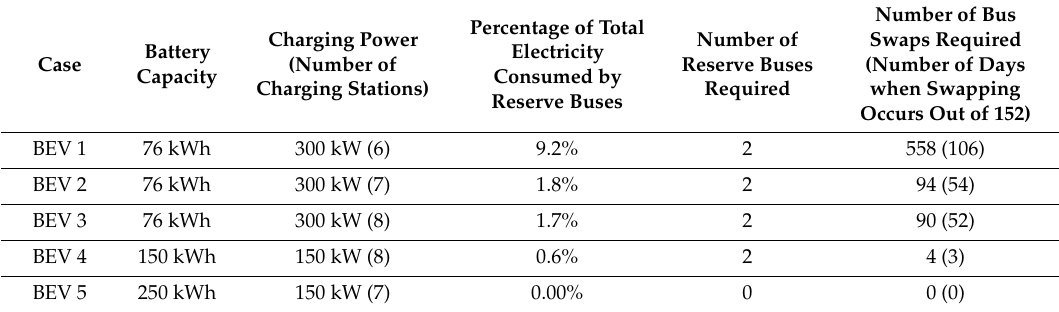
Table 4. BEV fleet simulation results for di ff erent number of charging spots (located at end stations and